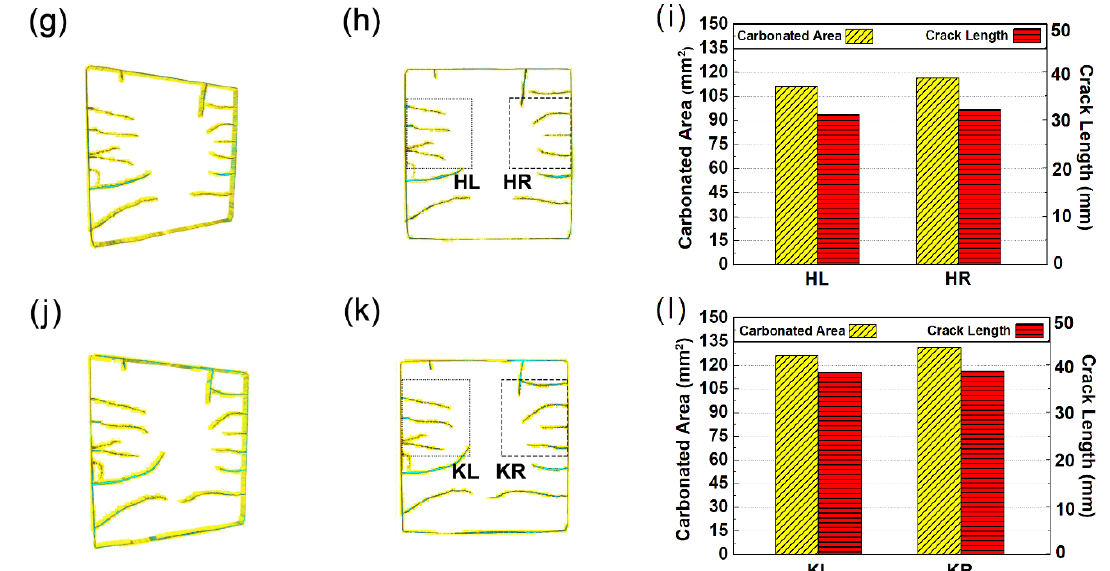
Figure 9. Spatial renderings for the propagated cracks: ( a , d , g , j ) show the 3D map of propagated cracks after 3, 7, 14, and 28 days of carbonation, respectively; ( b , e , h , k ) show the 2D map of propagated cracks formed after 3, 7, 14, and 28 days, respectively; ( c , f , i , l ) show the carbonated area and total crack length based on the related 2D map on its left.